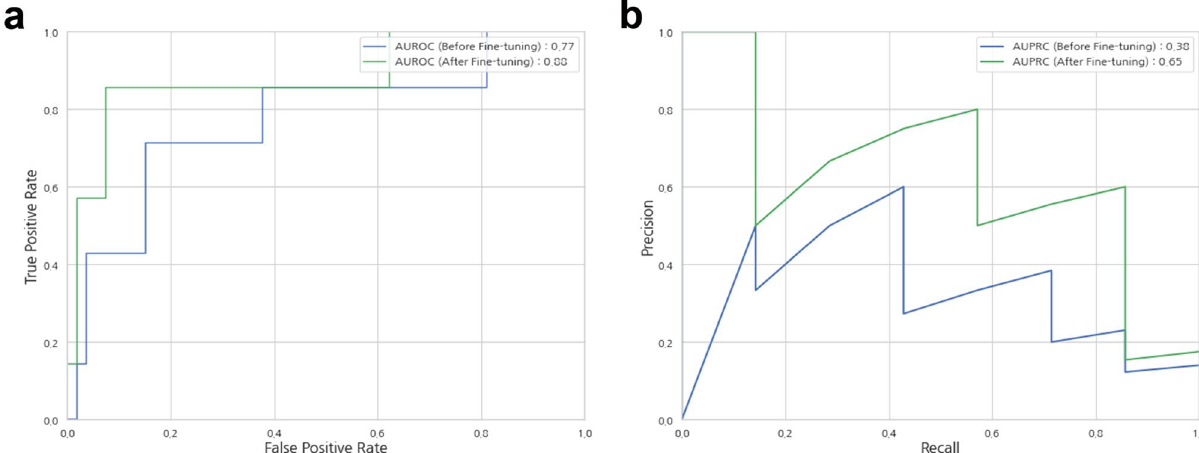
Figure 3. Performance of the models. The area under the receiver operating characteristic (AUROC) curve ( a ) and area under the precision-recall curve (AUPRC) ( b ) of slide-level EBV status inference using the original classifiers solely trained with TCGA dataset (blue) and re-weighted classifiers fine-tuned with ISH dataset (Supplementary Fig. S3). Of the four false positives, the algorithm falsely identified prominent lymphoid stroma and lymphoepithelial carcinoma (Supplementary Fig. S4A–C), and poorly cohesive carcinoma (Supplementary Fig. S4D), as EBV-positive tumors.